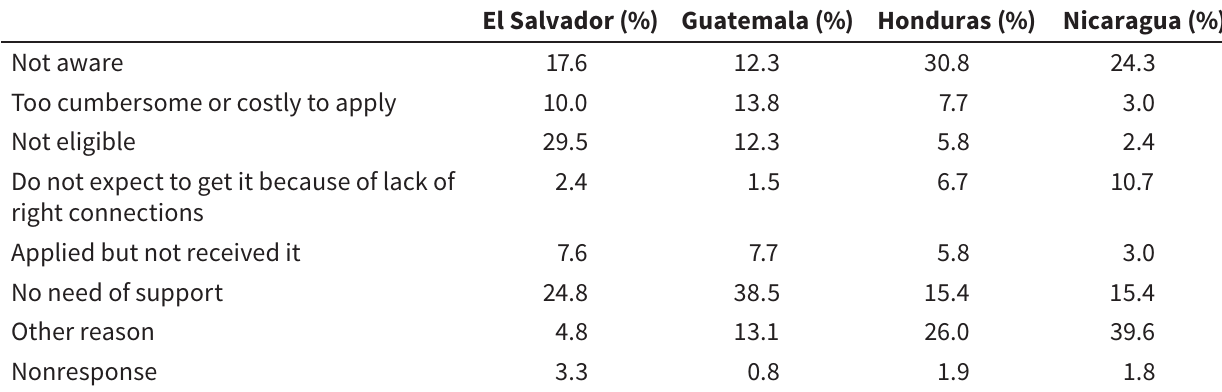
Reasons for not receiving government support (percentage of firms) El Salvador (%) Guatemala (%) Honduras